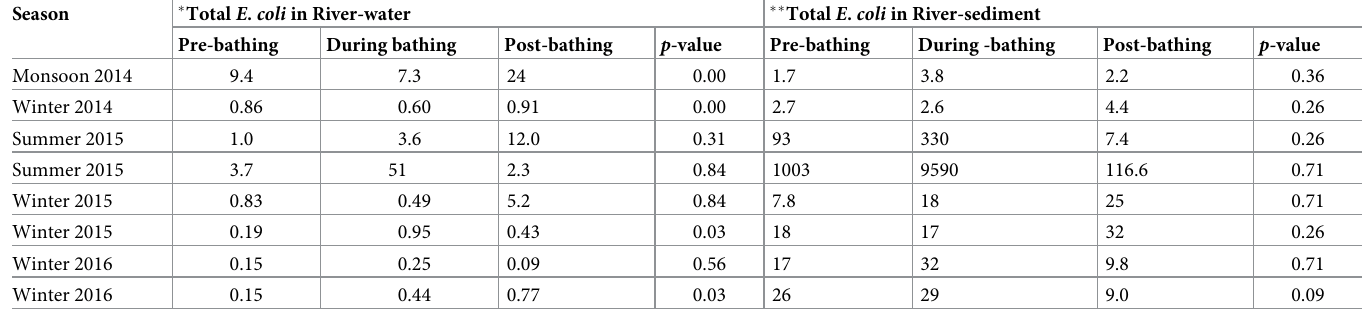
Table 3. Mean number of E . coli collected during mass-bathing at different time-points from river-water and -sediment of river Kshipra, Central India (Friedman test). Season